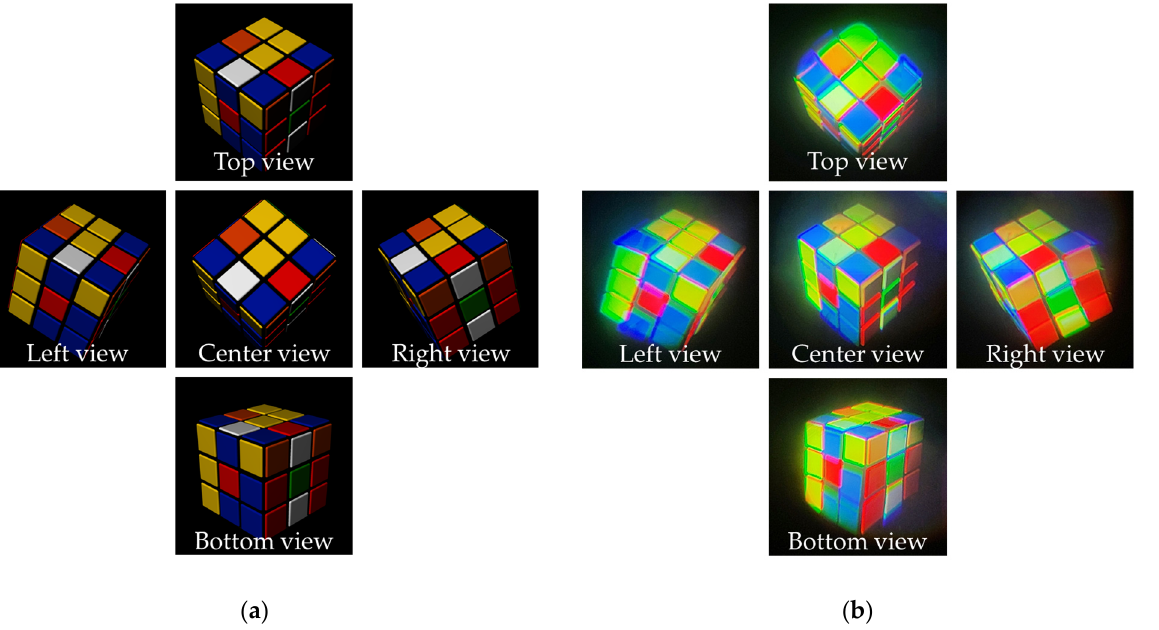
Figure 13. Experimental results. ( a ) Target images and ( b ) images captured according to viewing angles at − 20 degrees left, +20 degrees right, 20 degrees top, and − 20 degrees bottom.